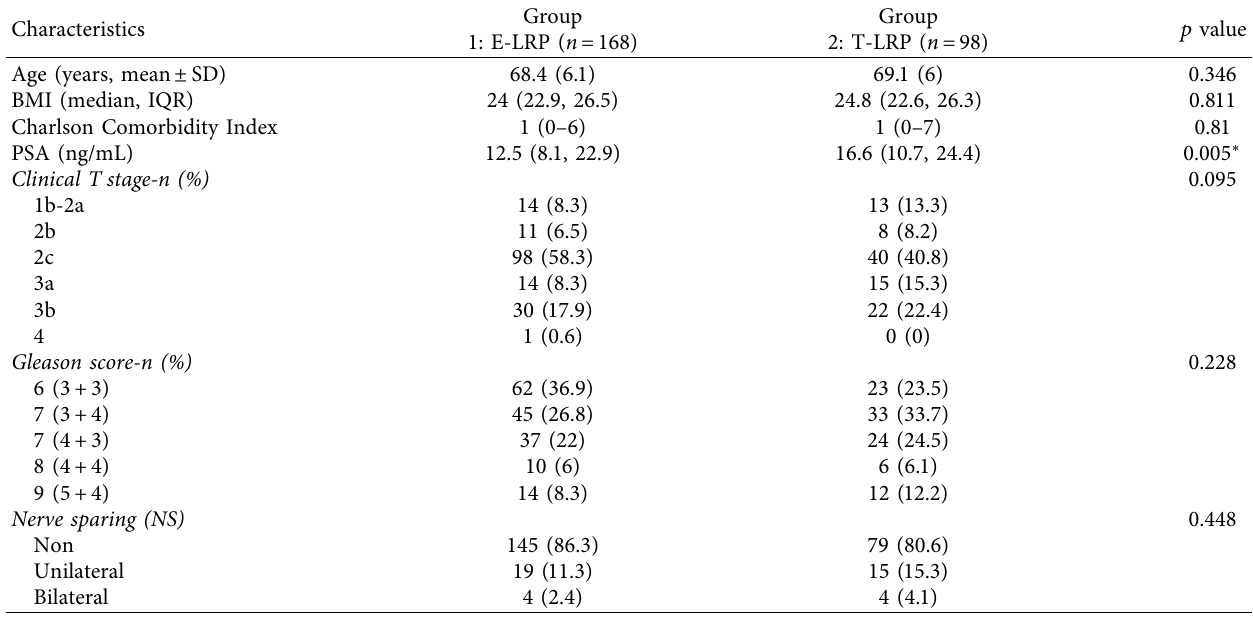
Table 1: Demographics and clinical characteristics of the study population between extraperitoneal and transperitoneal approach. Characteristics